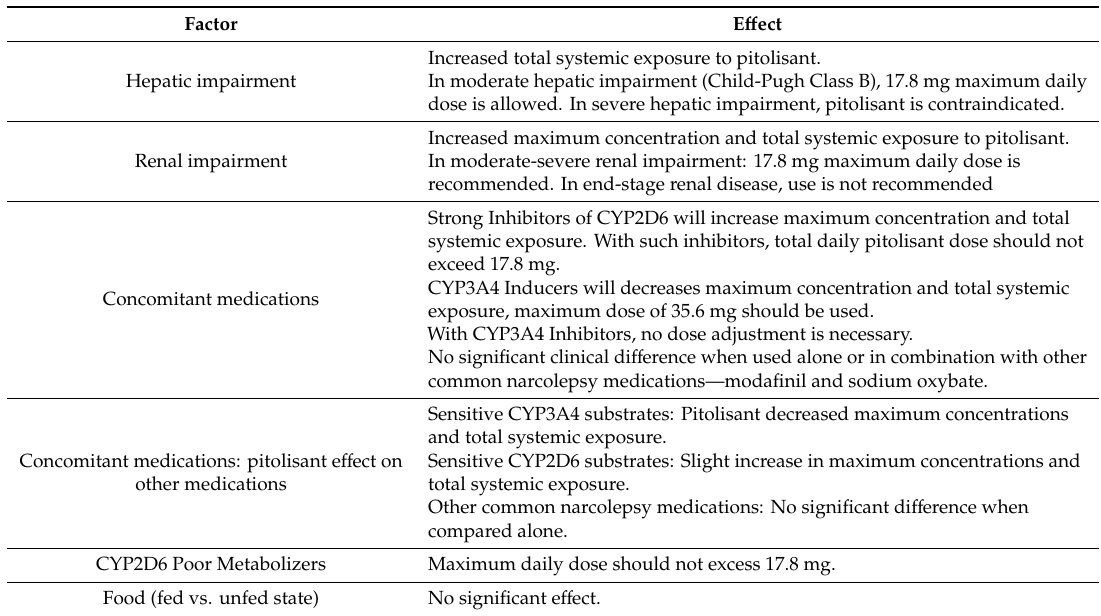
Table 1. E ff ect of variable factors on the pharmacokinetic parameters of pitolisant.